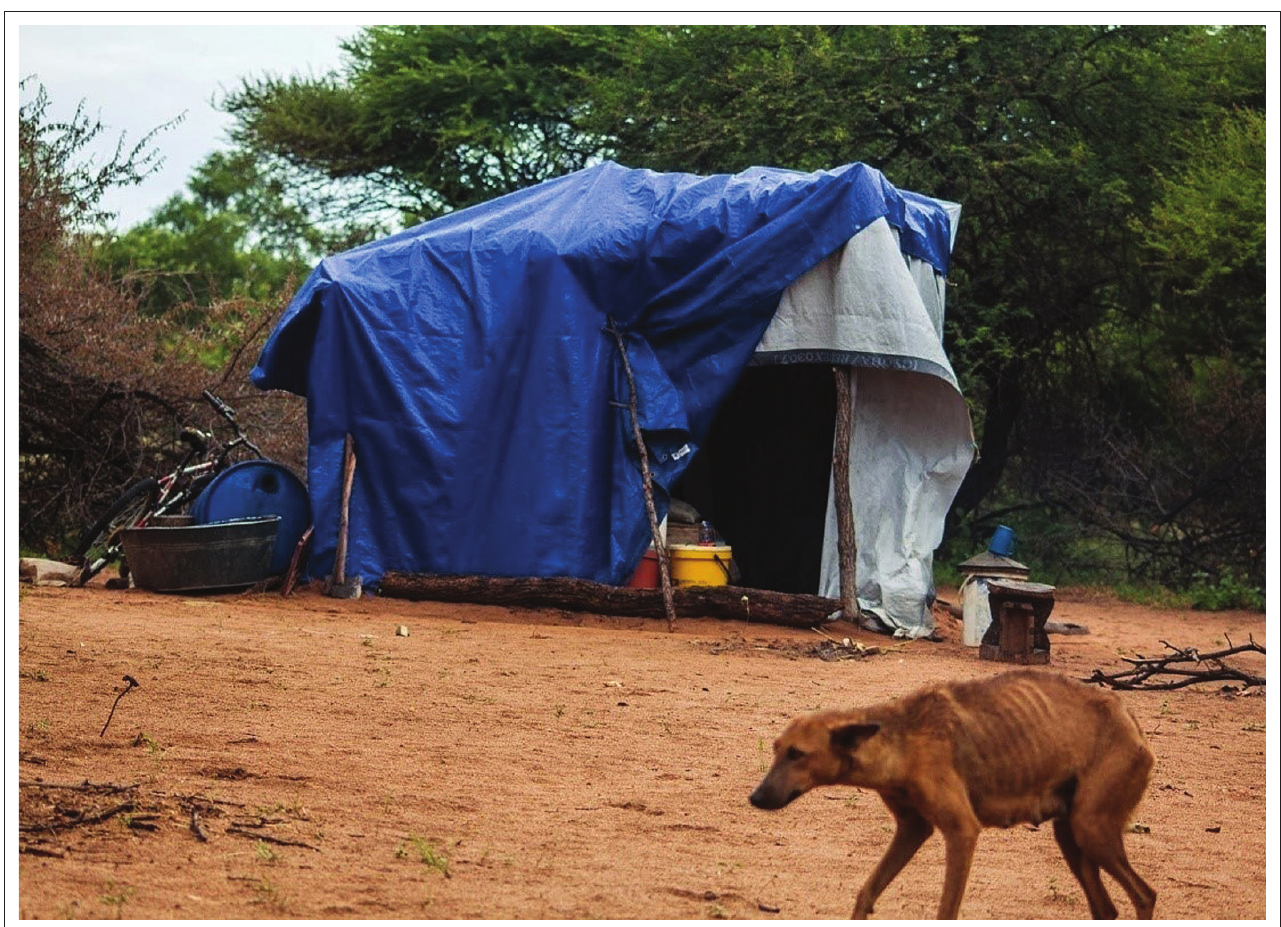
FIGURE 2: A tent that has been converted into a permanent dwelling at Butabubili